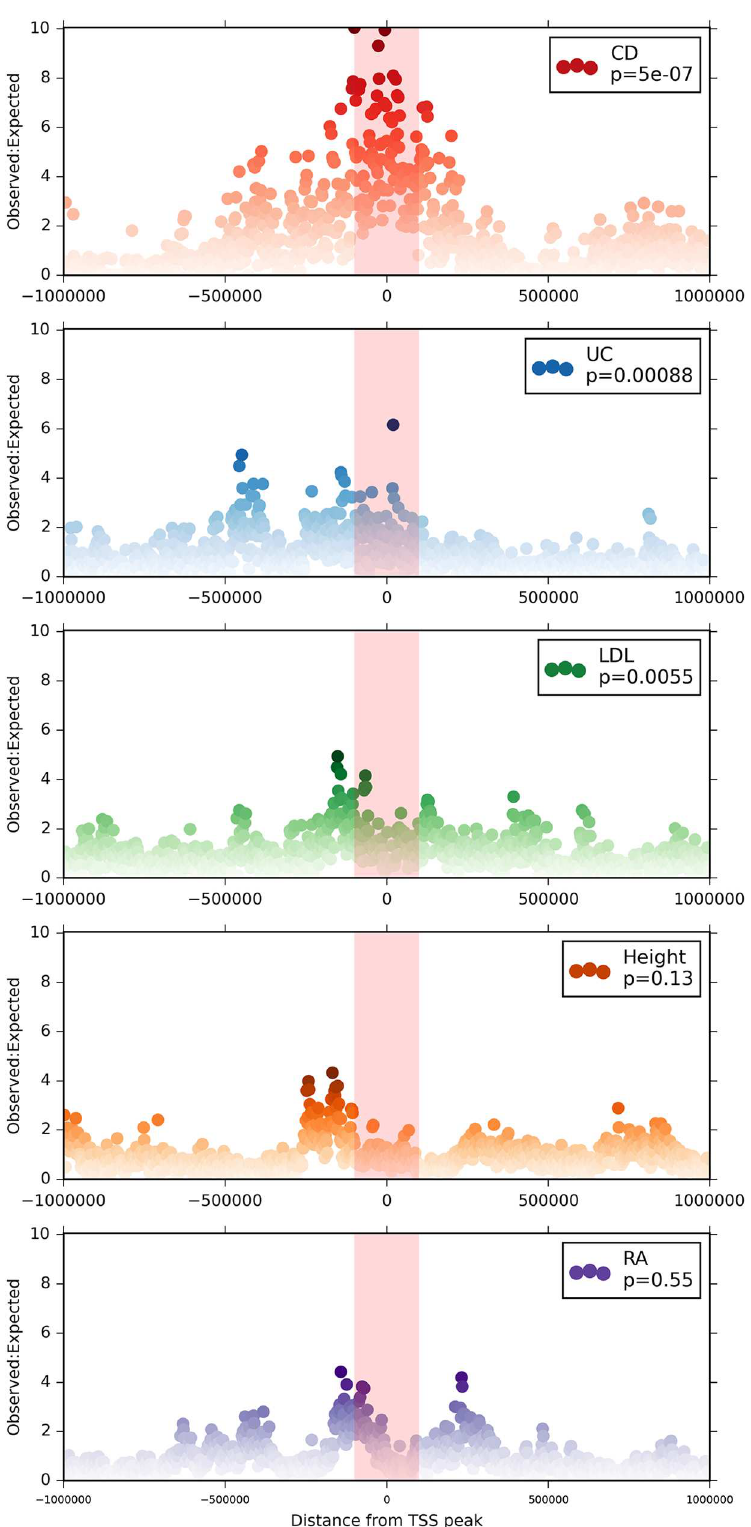
Fig 7. Enrichment of macrophage-expressedor regulated genes in genomic regions associatedwith IBD susceptibility Each panel shows the enrichment of GWAS-associated variants in vicinity of